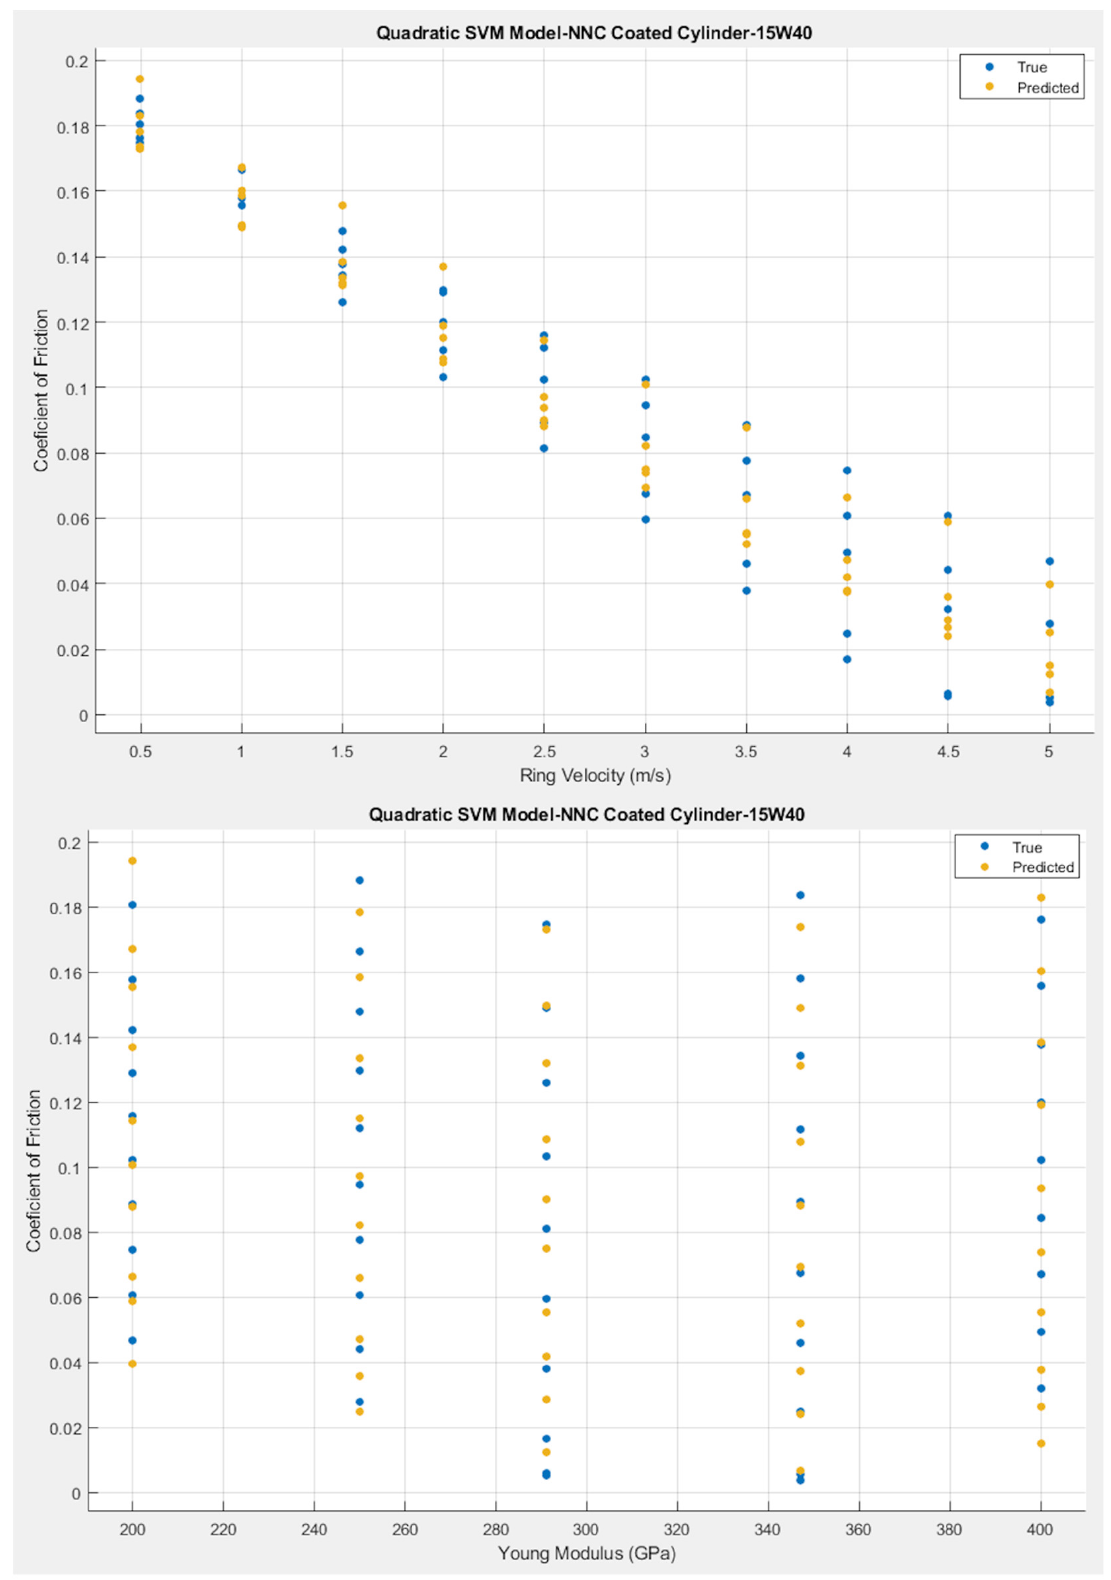
Figure 7. Quadratic SVM regression model of SAE 15W40 for an NNC cylinder liner.